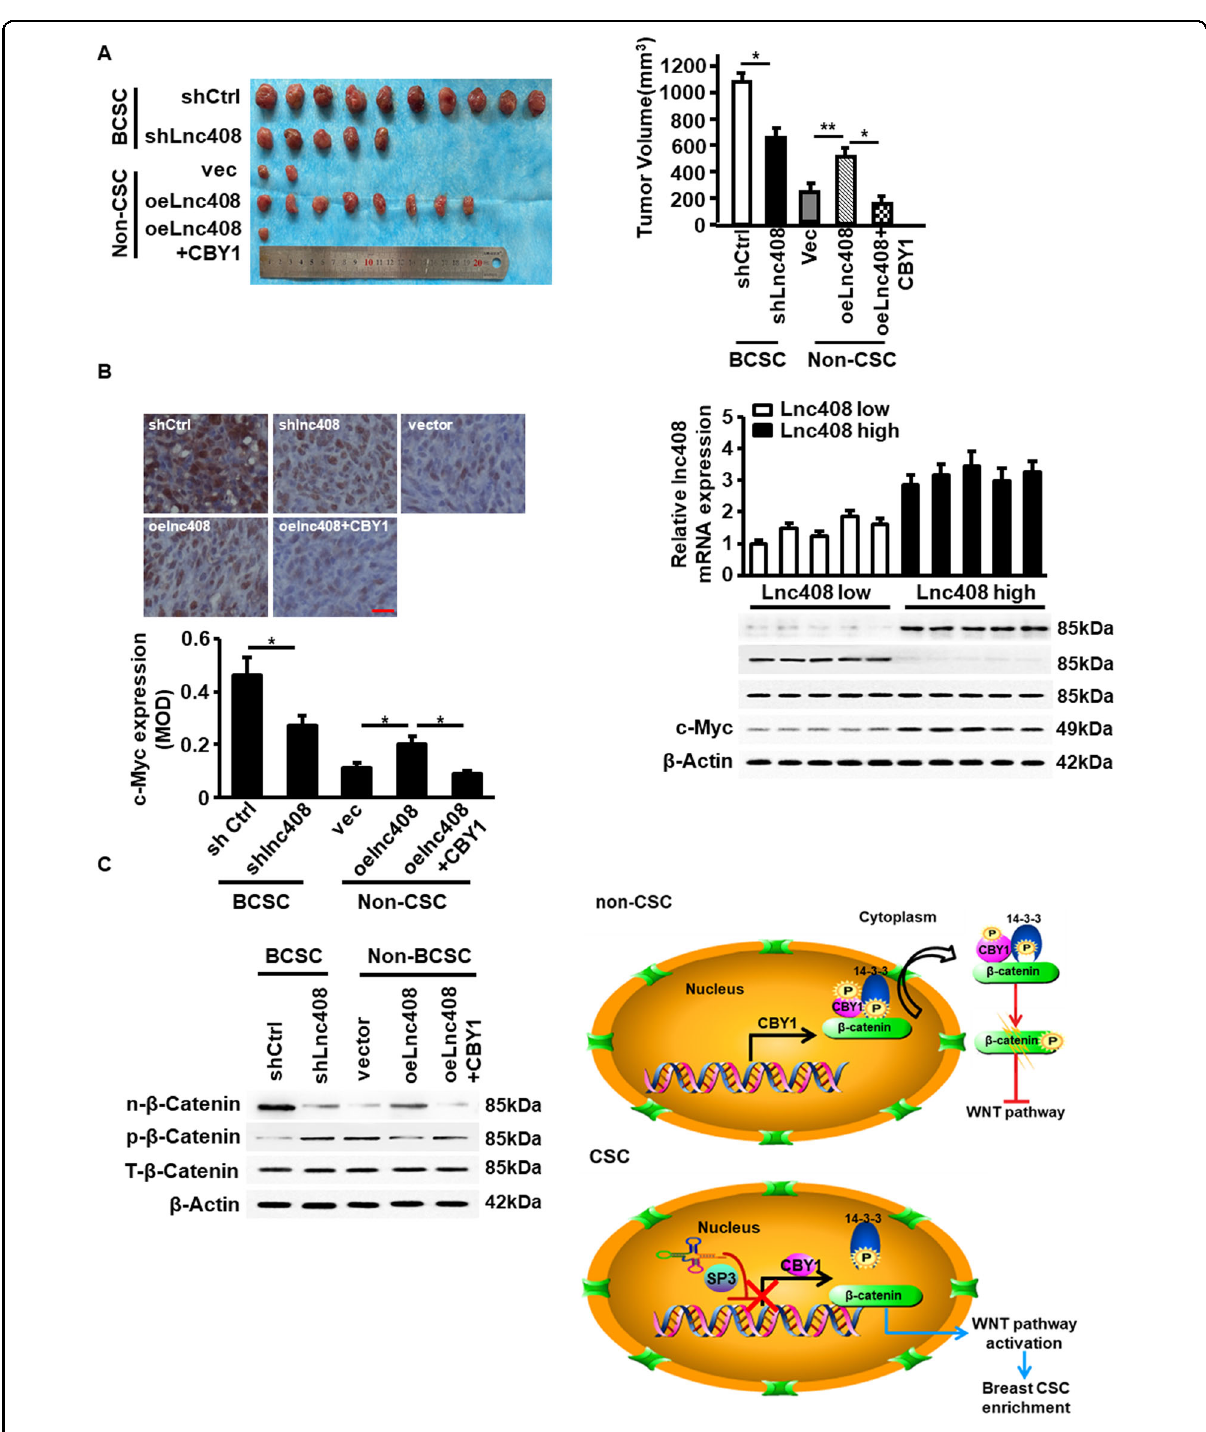
Fig. 7 Lnc408/CBY1 axis promotes tumorigenesis of BCSCs in vivo. A The tumor initiation and tumor sizes of each group (* P < 0.05, ** P < 0.01). B Representative pictures of IHC staining of c-Myc proteins (upper panel) and c-Myc mRNA levels (down panel) in each group (* P < 0.05; scale bar, 50 μ m). C Protein levels of nuclear, phosphorylated, and total β -catenin in tumors were determined by western blotting. D Clinical samples were divided into lnc408 high and low expression groups according to lnc408 expression levels, and subjected to western blotting to assess nuclear β -catenin, total β -catenin, and c-Myc expressions. E A schematic model to illustrate lnc408 molecular functions in BCSCs. Lnc408 recruits SP3 to impair CBY1 transcription, the reduced CBY1 lose or signi fi cantly incapacitated its ability to form complex with 14-3-3 and β -catenin in CSCs, which notably mitigate the transportation of β -catenin into cytoplasm, to lead an accumulation of nucleus β -catenin, thus triggers the WNT/ β -catenin signaling to maintain BCSCs